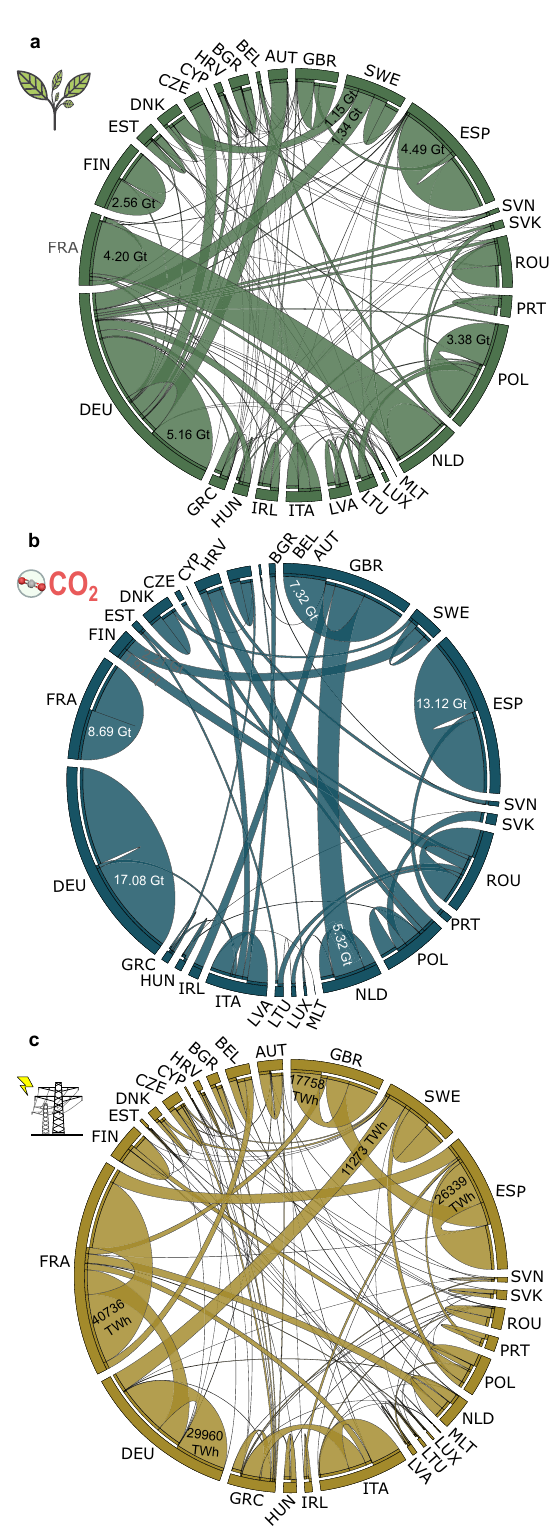
CO 2 , with, for example, Sweden, the United Kingdom, and Romania acting as net importers and the Netherlands,